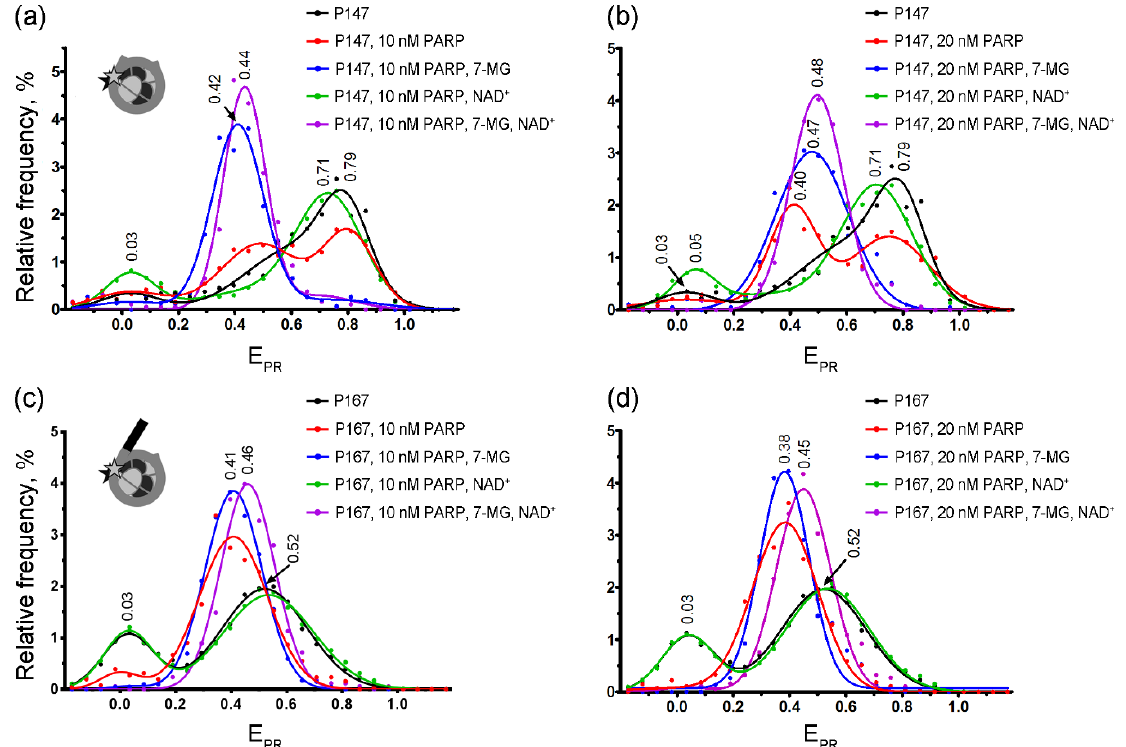
Figure 4. spFRET studies of 7 ‐ MG effects at the nucleosome level. Typical frequency distributions of P147 ( a , b ) and P167 ( c , d ) nucleosomes by E PR in different mixtures are shown. Conditions: 1 nM nucleosomes, 10 nM or 20 nM PARP ‐ 1, 100 μ M NAD + , 450 μ M 7 ‐ MG. Inserts: schemes of nucleosome structure and positions of fluorescent labels (asterisks).